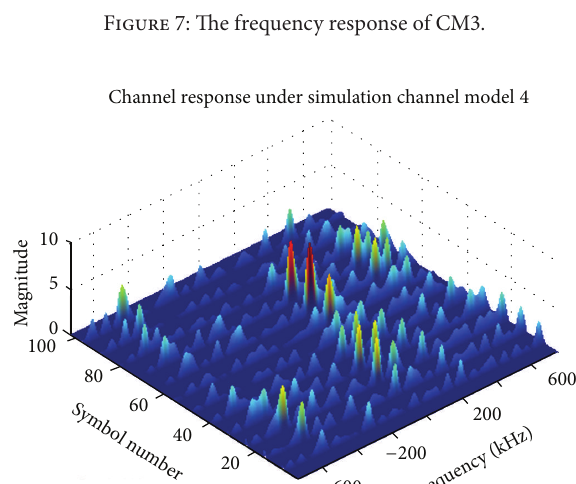
Figure 7: The frequency response of CM3.